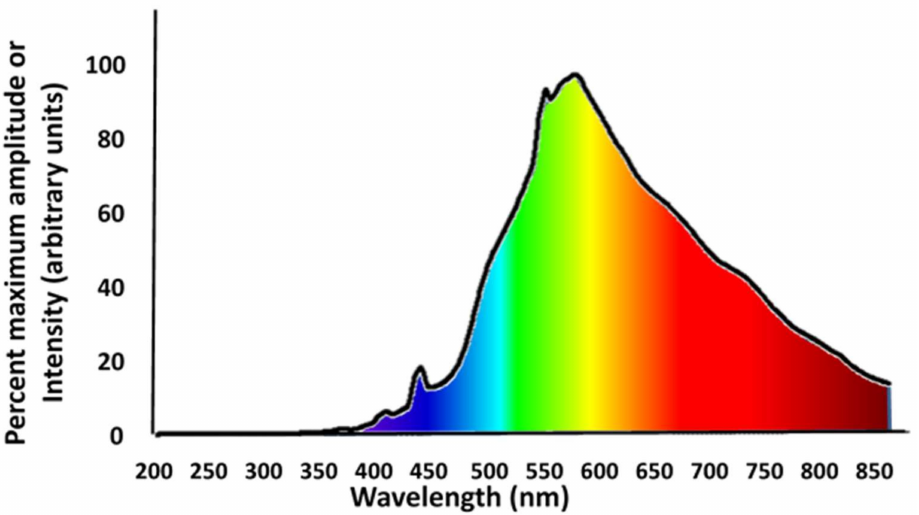
Figure 1. Spectral distribution of light from one representative LED lamp used to produce day- and night-lighting in our experiments measured with a StellarNet EPP2000C reflectance spectrometer. All light levels were measured using an IL1700 Research Radiometer (International Light, Peabody, MA, USA) with SHD033 detector and ZCIE scotopic and Y photopic light filters to measure illuminations (lx) at a 45-degree angle relative to the substrate of a salamander’s container at the center of each chamber. Radiometric measurements (W/cm 2 ) obtained using an EPP2000C reflectance spectrometer (StellarNet, Tampa, FL, USA) with (a representative spectrum is presented in Figure 1). The lightguide for the reflectance spectrometer was held at a 45-degree angle to a 50 mm RS50 white halon 97%